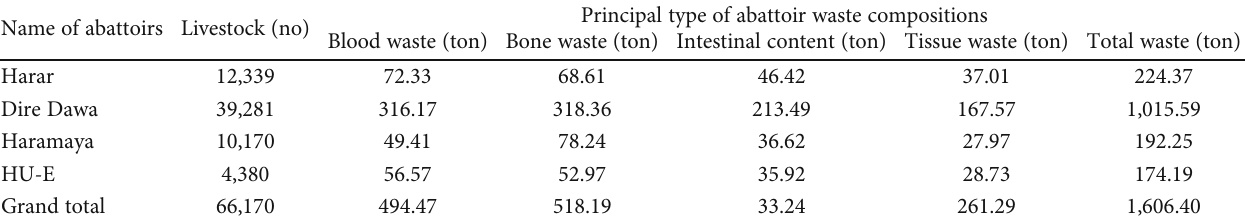
Table 1: Annual slaughtered livestock and estimated abattoir waste from the selected abattoirs, 2019. Principal type of abattoir waste Name of abattoirs Livestock (no)